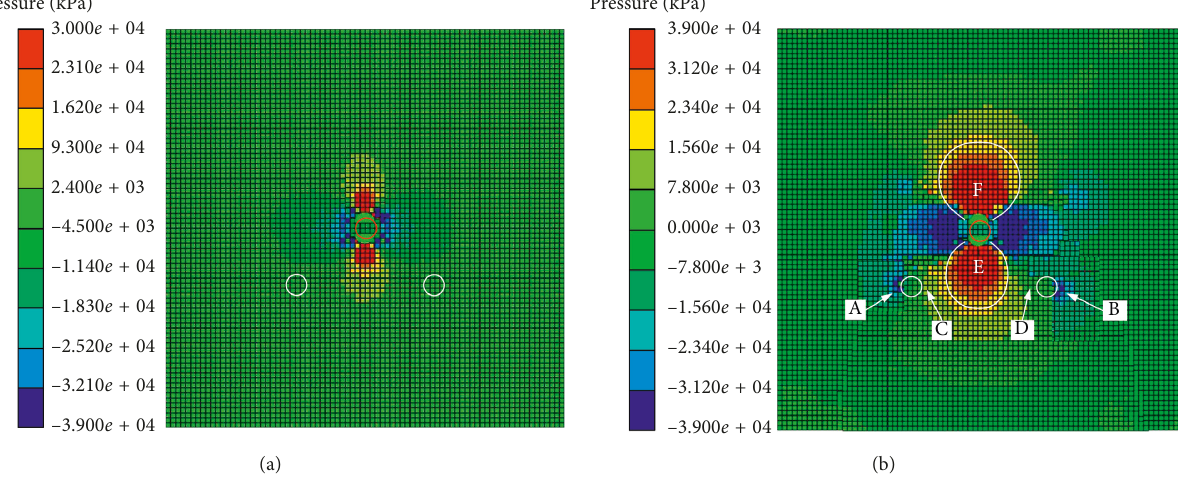
Figure 13: Equivalent effective stress nephogram of the auxiliary hole-assisted fracturing process at α � 40 ° : (a) wedge contact predrilled fracturing hole; (b) stress concentration around auxiliary